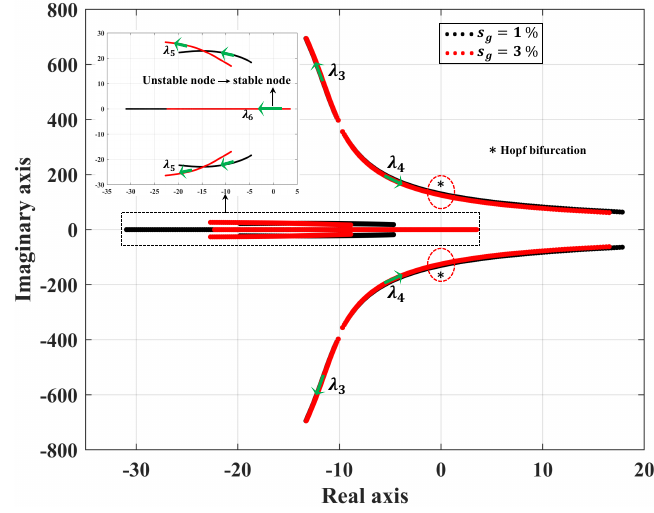
Figure 4. Eigenvalue trajectories for low and high generator slips. Table 1. Eigenvalues of SCIG-WT for 60% series compensation and s g = 1%.